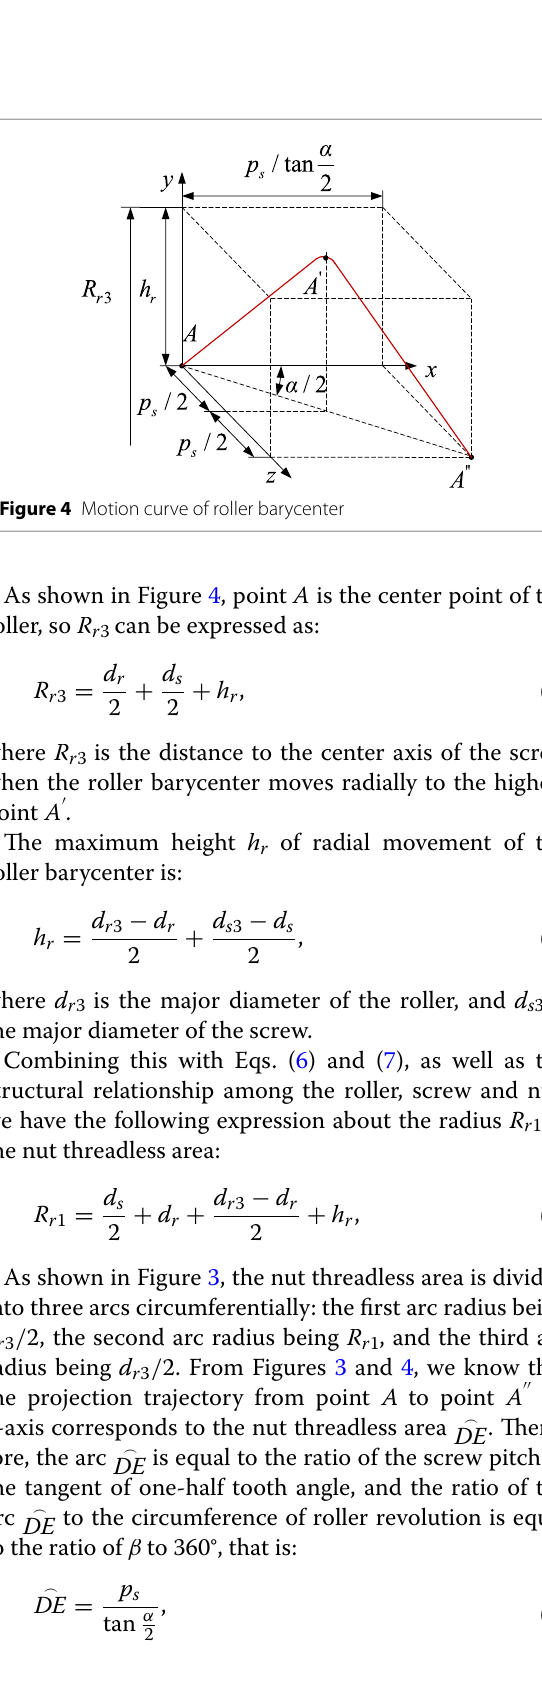
Figure 4 Motion curve of roller